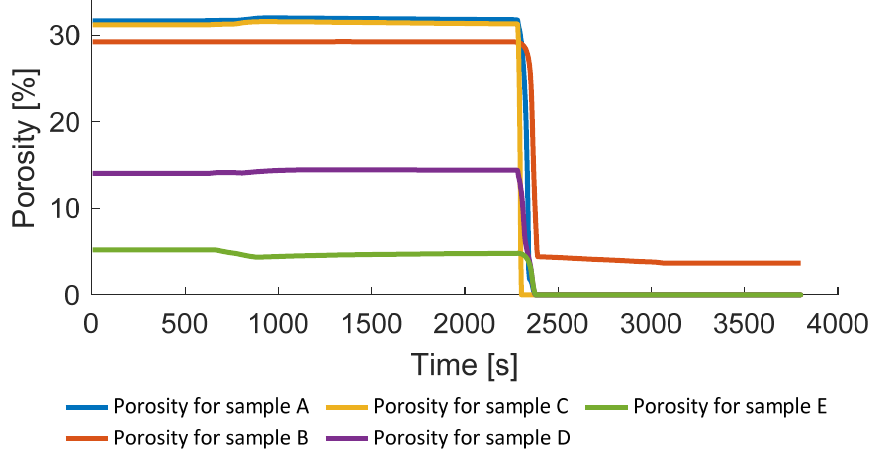
Figure 14. Porosity evolution during the consolidation.